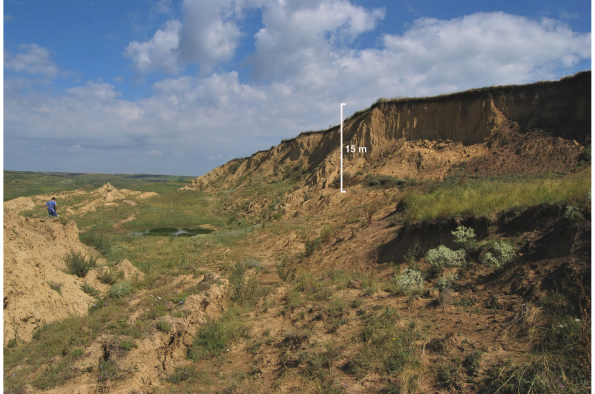
Fig. 3. Deep seated landslide in the Moldavian Plateau (¸Sipote sec- tor).